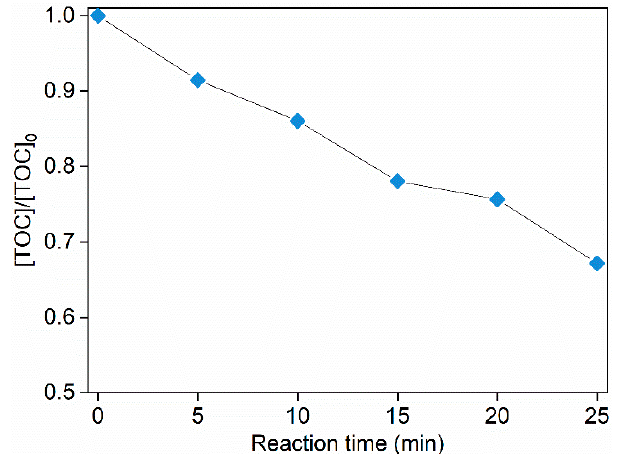
Figure 5. TOC evolution during degradation of ACE by O 3 / PMS. Conditions: [ACE] 0 = 8.0 mg · L − 1 ; pH = 7.4; 15 ± 1 ◦ C; O 3 dosage 1.25 ± 0.1 µ M · min − 1 (60 ± 5 µ g · min − 1 ); [PMS] 0 = 0.4 mM.